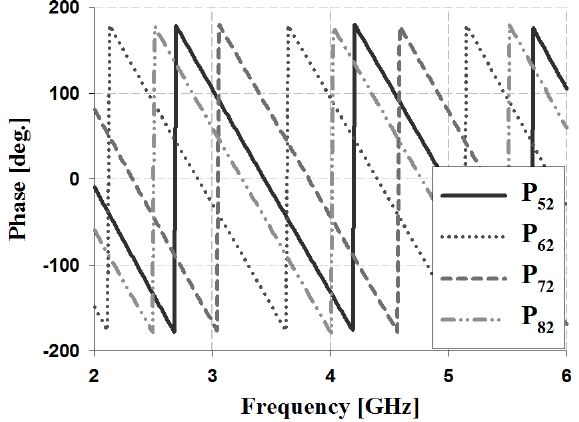
Figure 13. Simulation analysis of phase difference for input Port 1.